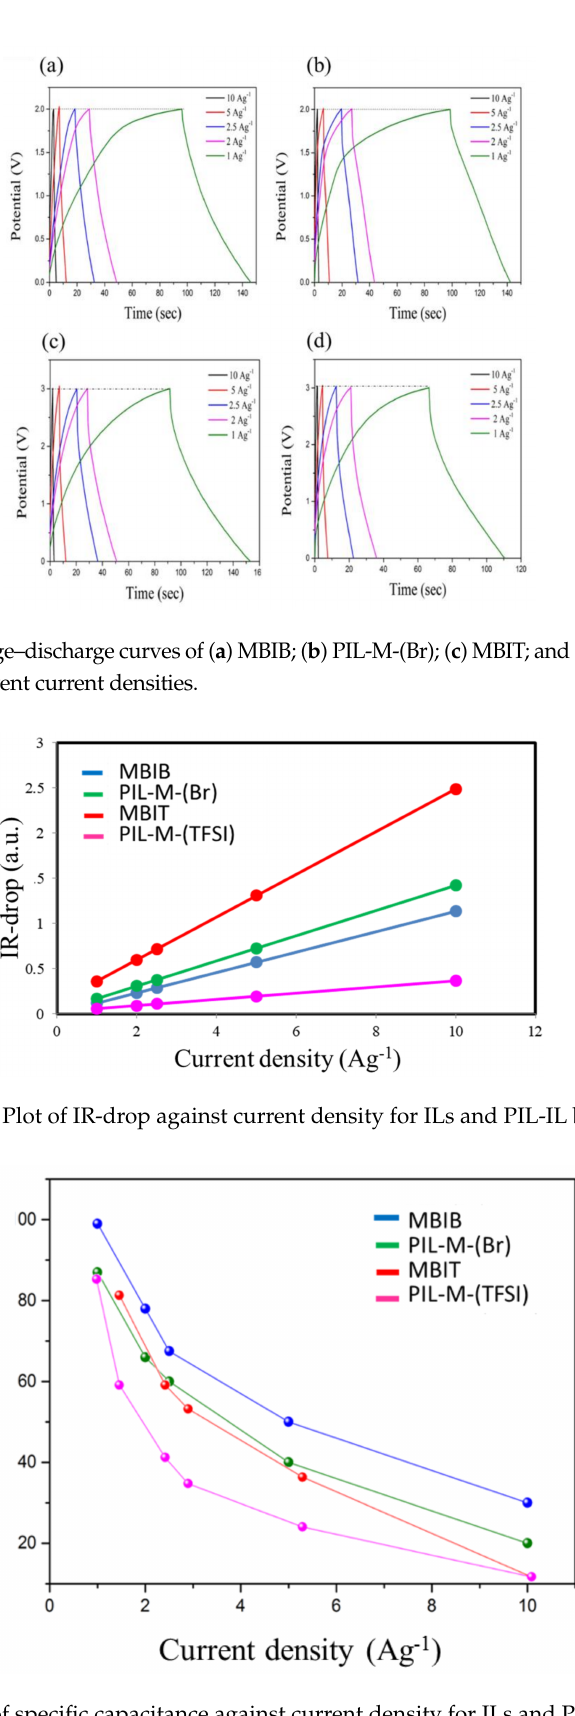
Figure 11. Plot of specific capacitance against current density for ILs and PIL-IL